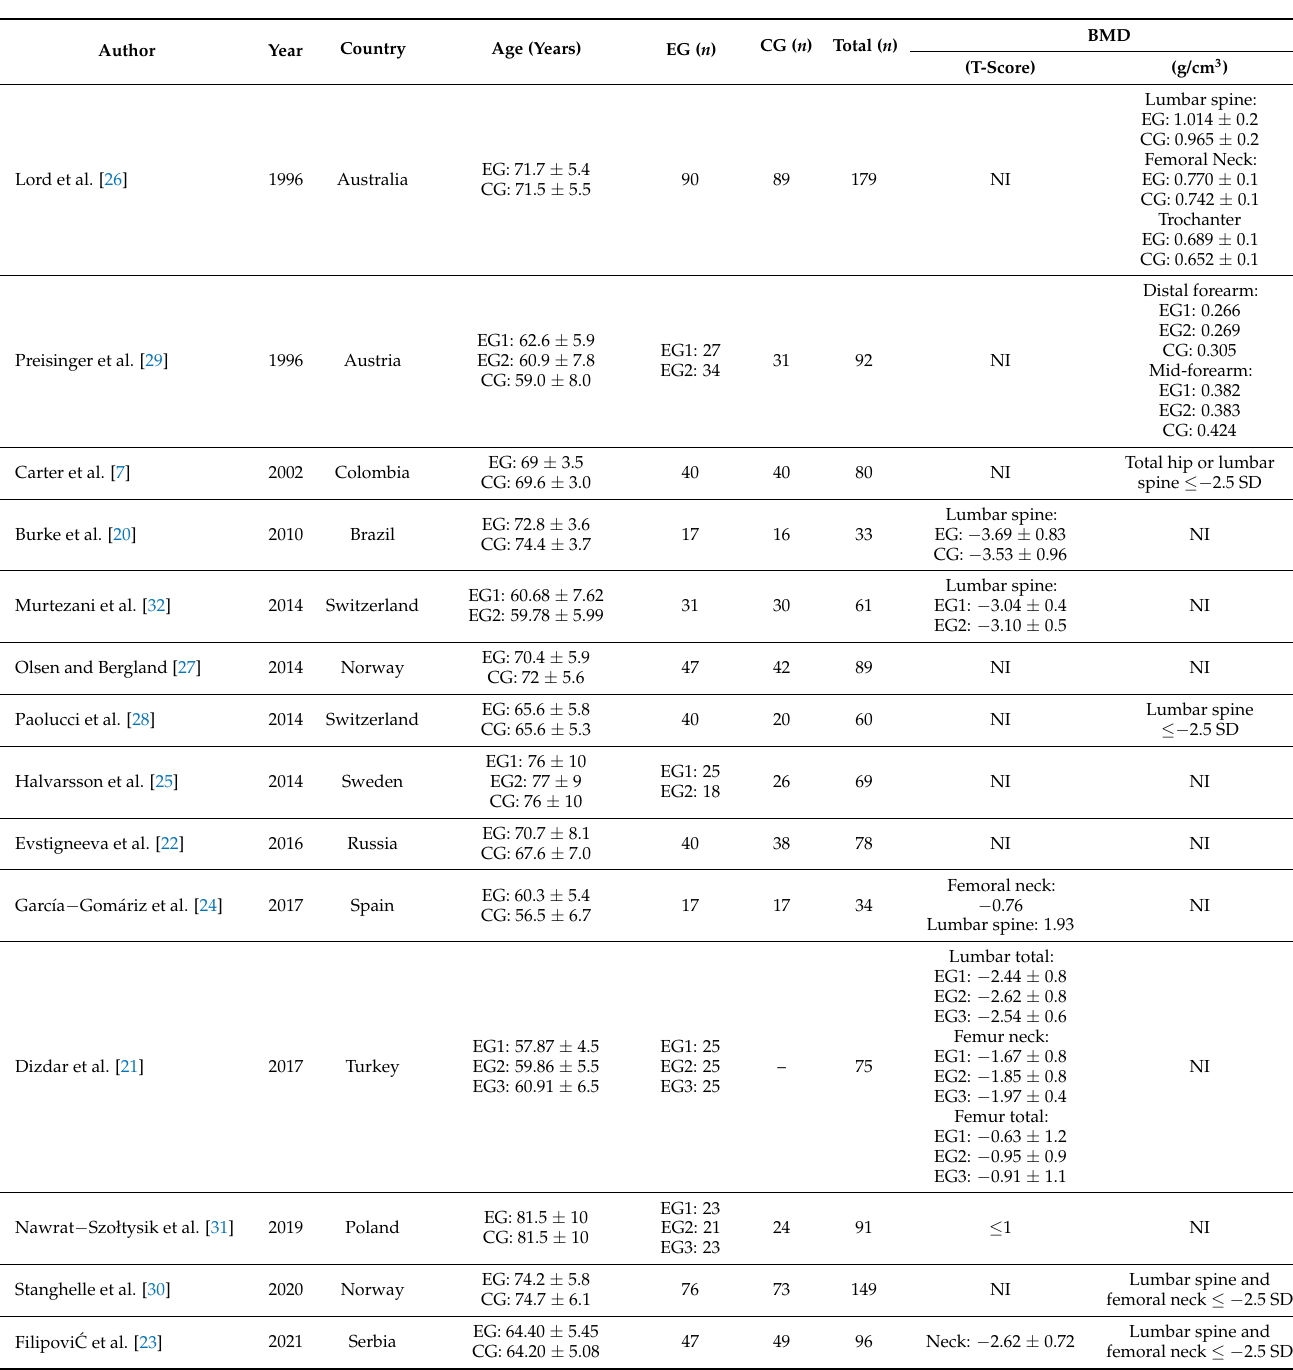
Table 3. Characteristics of the participants of the included